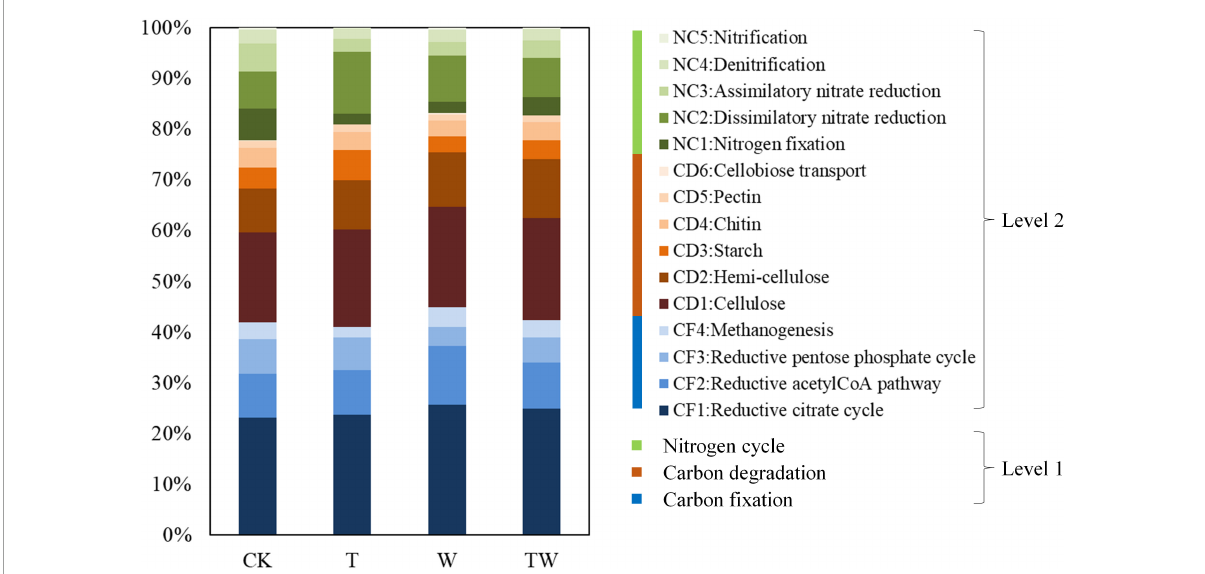
FIGURE7 Soil microbial functional genes associated with carbon and nitrogen cycle based on KEGG. CK, control; T, increasing temperature; W, increasing precipitation; TW, their